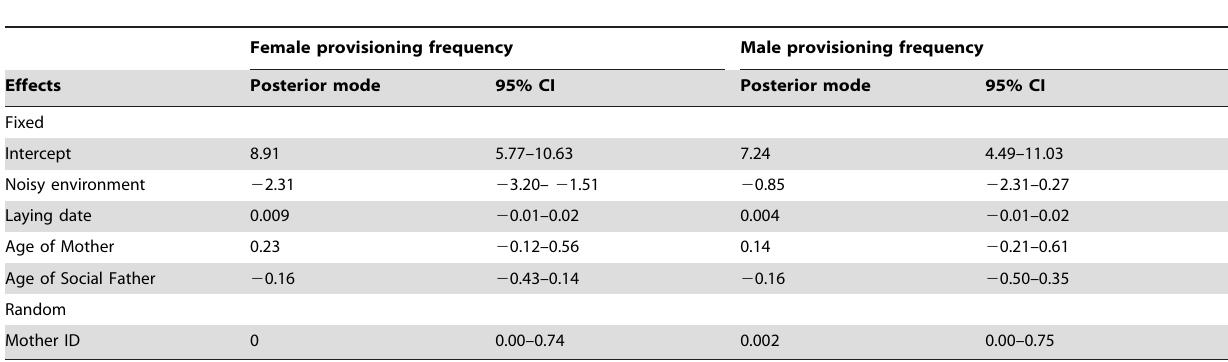
Table 2. Results of a BMM modelling Lundy island house sparrow provisioning frequencies (visits/hour) on day 7 in quiet and noisy environments. Statistically significant fixed effects are indicated in